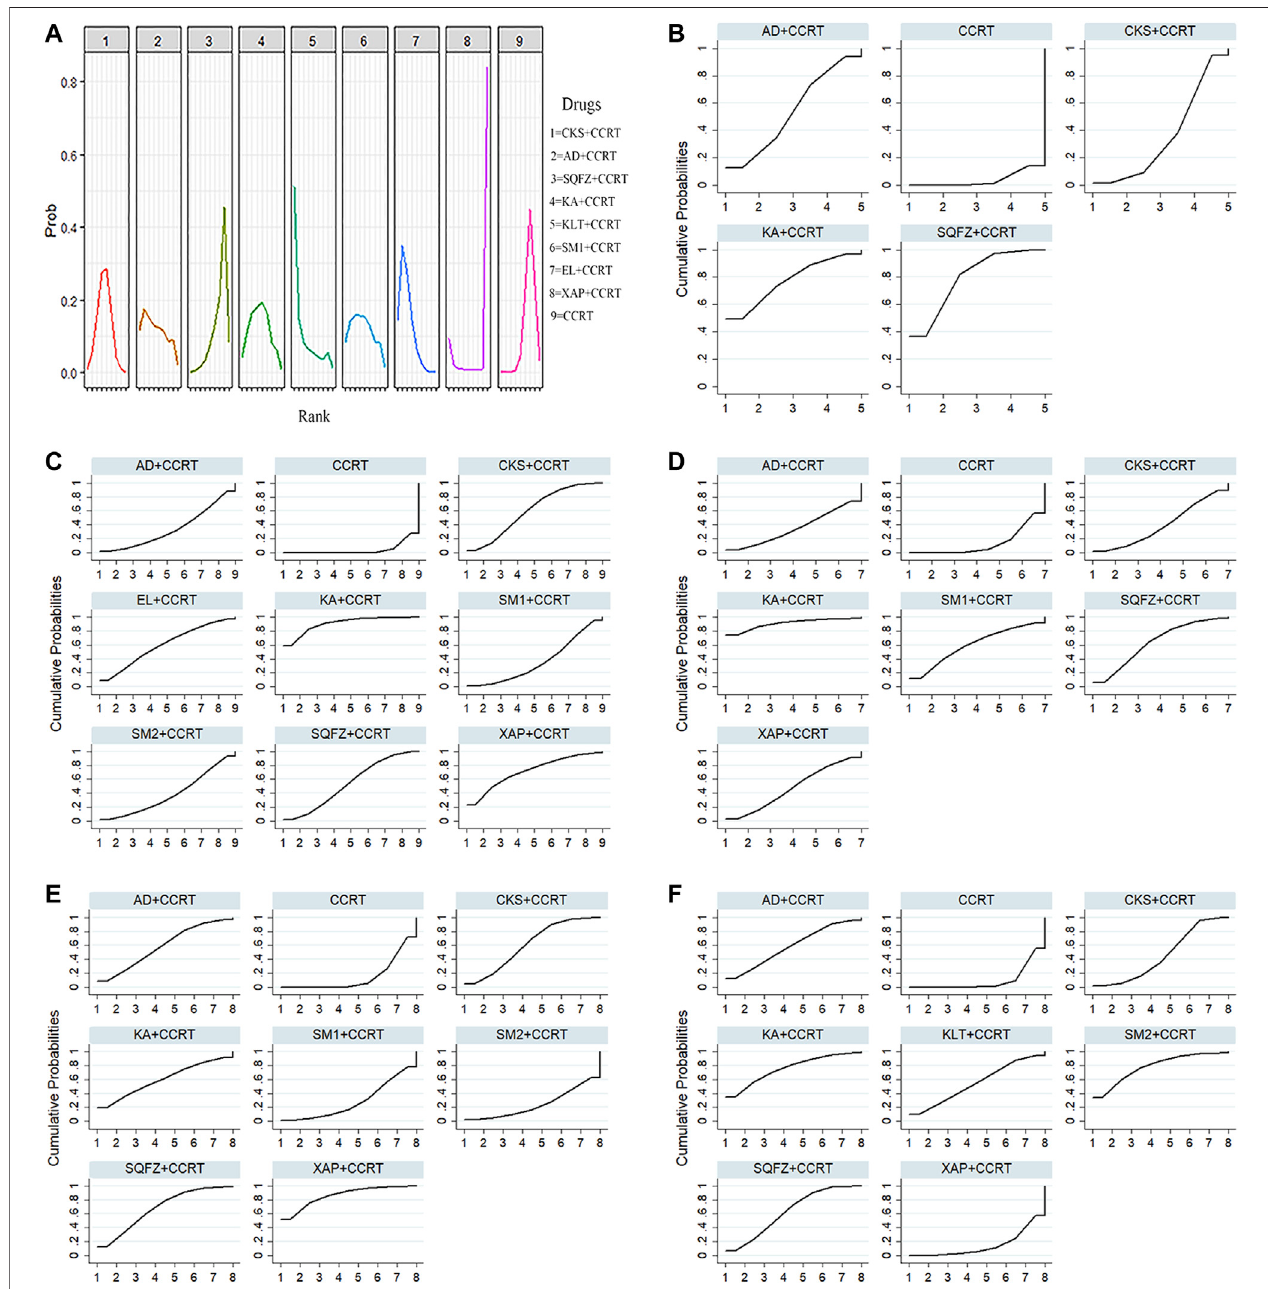
FIGURE4| RankprobabilitiesandSUCRAfordifferentoutcomes. (A) Therankprobabilityofclinicaleffectiverate, (B) SUCRAofperformancestatus, (C) SUCRAof leukopenia, (D) SUCRA of thrombopenia, (E) SUCRA of nausea and vomiting, and (F) SUCRA of grade ≥ 3 oral mucositis. Note: (AD, Aidi injection; CCRT, concurrent chemoradiotherapy; CKS, Compound Kushen injection; EL, Elemene injection; KA, Kangai injection; KLT, Kanglaite injection; SM1, Shengmai injection; SQFZ, Shenqifuzheng injection; SM2, Shenmai injection; and XAP, Xiaoaiping injection).